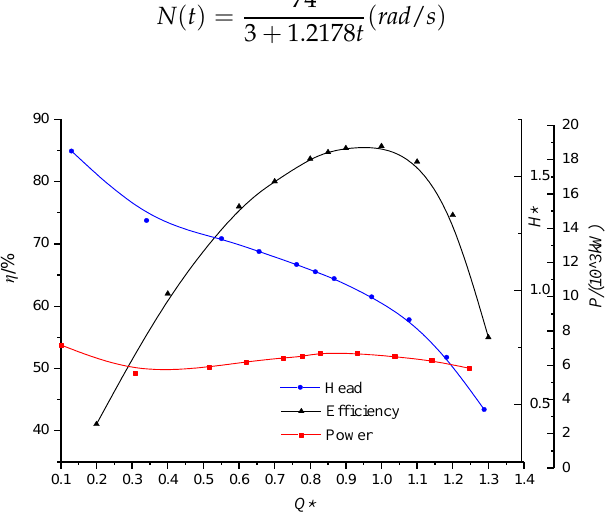
Table 6. Geometry parameter size of guide vanes.